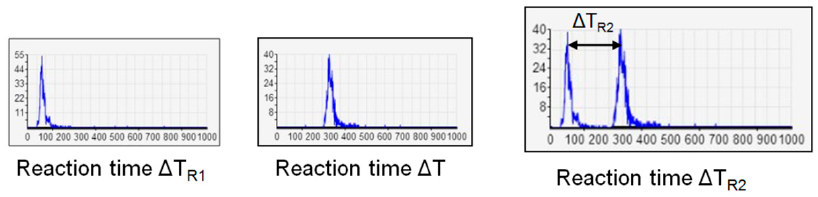
Figure 18. Determination of the reaction time of a SICS controller.